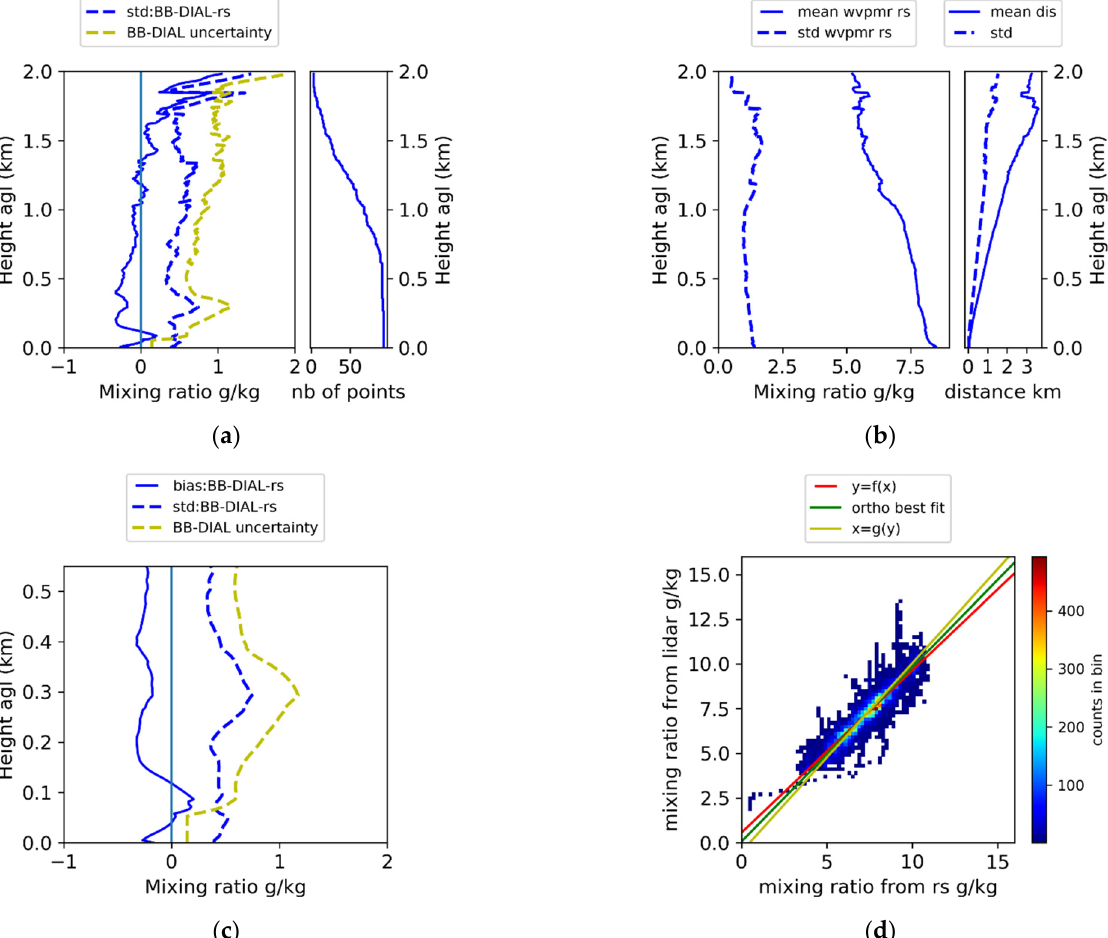
Figure 7. Summaries of the comparison between BB-DIAL and the 93 radiosonde ascents for the entire evaluation period (15 June–16 July 2020): ( a ) bias (BB-DIAL-radiosonde), std deviation, BB-DIAL uncertainty variation with height and number of data points used; ( b ) climatology of the dataset: mean mixing ratio and standard deviation, ( b ) right: mean range from radiosonde launch point and standard deviation for the data used in the inter comparison; ( c ) zoomed on the lowest part of the radiosonde inter-comparison; ( d ) 2D histogram scatterplot BB-DIAL versus radiosonde, with corresponding statistics in Table 3, (data every 4.8 m above 50 m have been used in 7 ( d ) and (Table 3). Table 3. Statistical results corresponding with the scatter plot in Figure 7d.